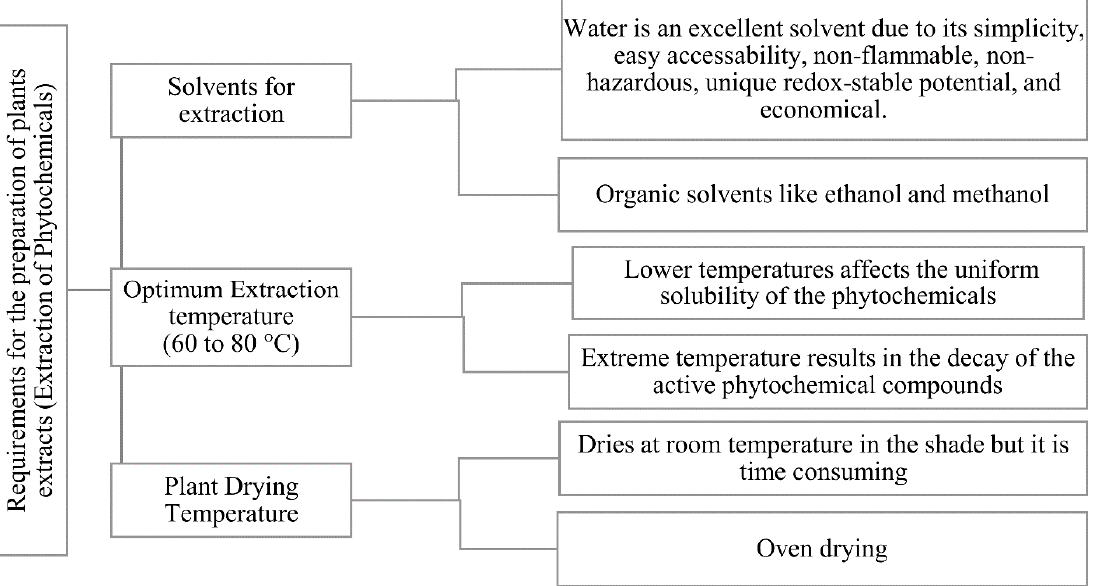
Figure 6. Parameters considered during the preparation of plant extract [51].